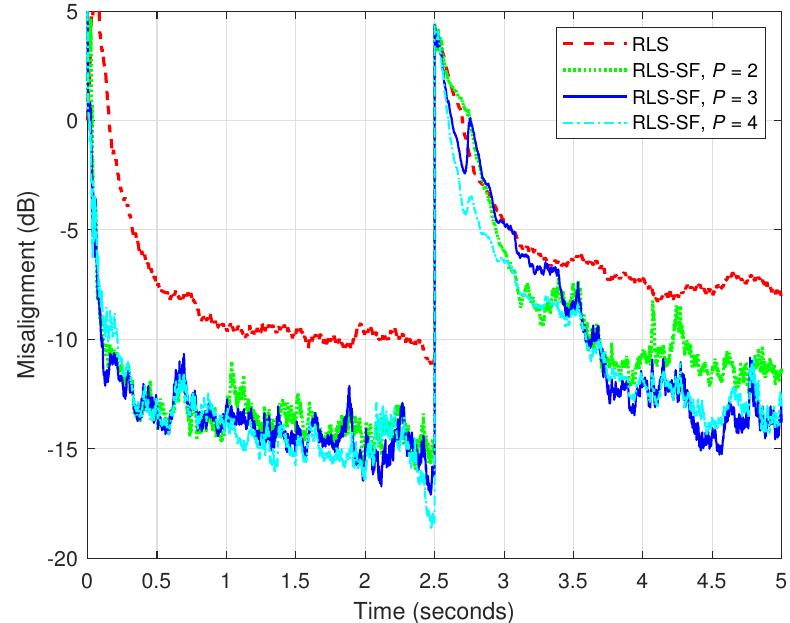
Figure 11. Performance of the conventional RLS filter [with λ = 1 − 1/ ( KL /2 ) ] and the RLS-SF [with λ 1 = 1 − 1/ ( 2 KPL 1 ) and λ 2 = 1 − 1/ ( 2 KPL 2 ) ], using K = 10, for the identification of the network echo paths from Figure 1a,b. The input signal is a speech sequence, SNR = 10 dB, and the echo path changes after 2.5